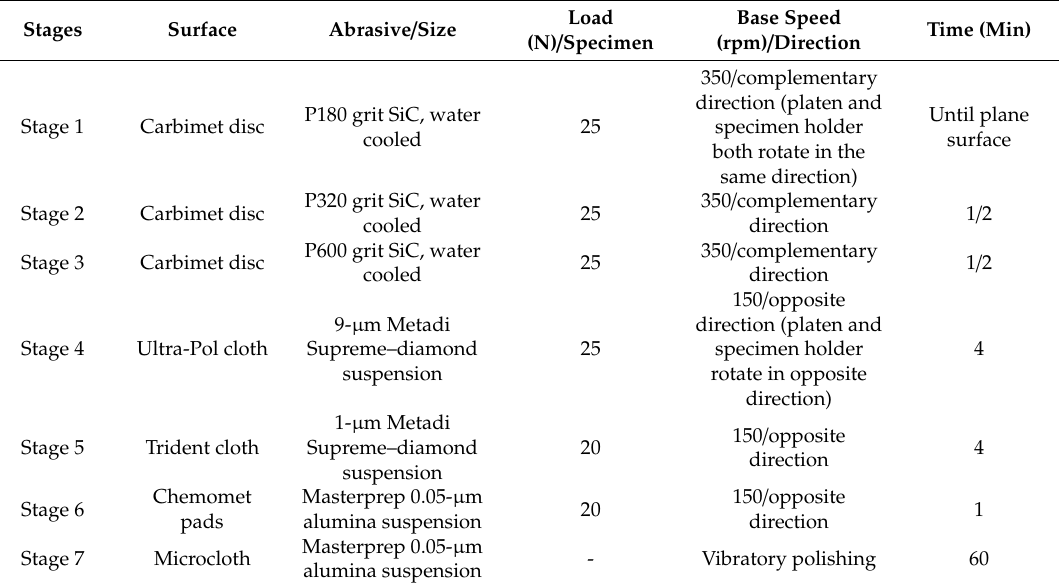
Table 1. Materials and parameters for specimen